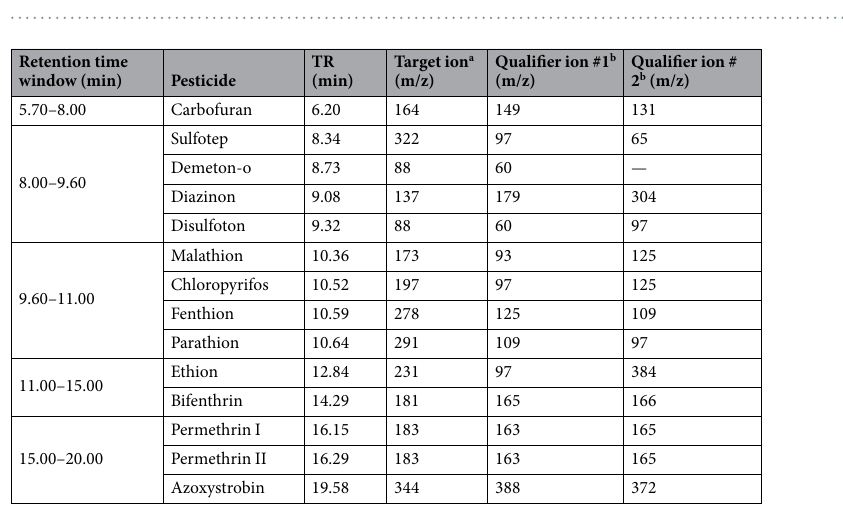
Figure 1. Chromatogram of a 7.5 µ g L − 1 standard solution containing 14 compounds analyzed by GC-MS in SIM mode. Compounds listed in elution order: [1] Carbofuran (6.20 min), [2] sulfotep (8.34 min), [3] demeton-O (8.73 min), [4] diazinon (9.08), [5] disulfoton (9.32 min), [6] malathion (10.36 min), [7] chloropyrifos (10.52 min), [8] fenthion (10.59 min), [9] parathion (10.64 min), [10] ethion (12.84 min), [11] bifenthrin (14.29 min), [12] permethtin I (16.15 min), [13] permethrin II (16.29 min), [14] azoxystrobin (19.58 min).